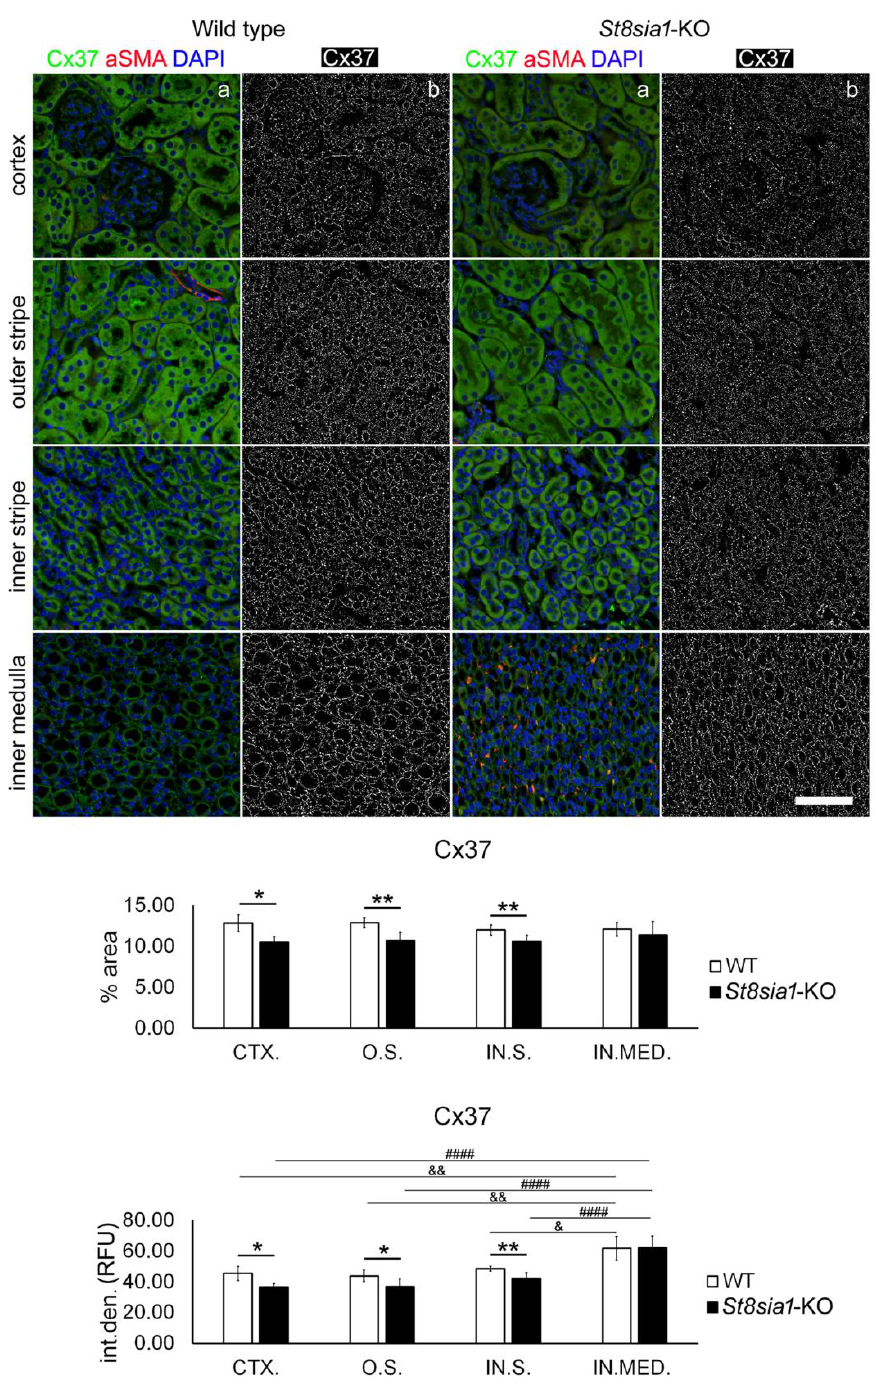
Figure 3. Expression of connexin 37 in different renal parts of the wild type and St8sia1 -KO mice. WT—wild-type mice; St8sia1 -KO— St8sia1 knockout mice; CTX.—Cortex; O.S.—outer stripe of outer medulla; IN.S.—inner stripe of outer medulla; IN.MED.—inner medulla; % area—percentage of the section area occupied by Cx37 immunofluorescence; int.den. (RFU)—integrated density (relative fluorescence units). Column a—representative photomicrographs of the indicated kidney section areas stained with Cx37 (green) and alpha smooth actin (aSMA, red) antibodies; cell nuclei are stained blue. Column b—(same section as a) processed and thresholded photomicrographs prepared for analysis (inverted black for white on tresholded green image). Statistically significant difference between WT and St8sia1 -KO: * p < 0.05; ** p < 0.01 (t-test for unequal variances). Comparison between different kidney areas in the same group — WT: & p < 0.05; && p < 0.01; or St8Sia1 -#### p <